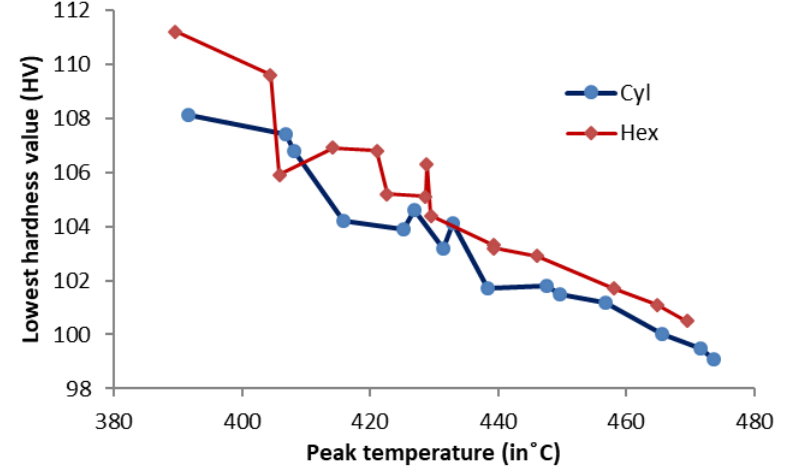
Figure 5. Effect of temperature rise on the harness value in